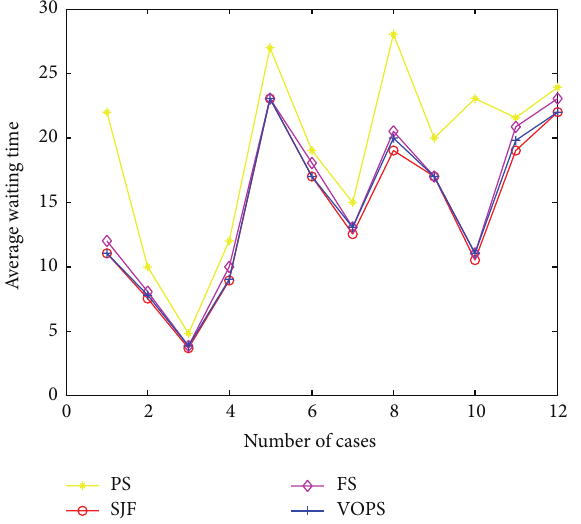
Figure 11: Average normalized turnaround